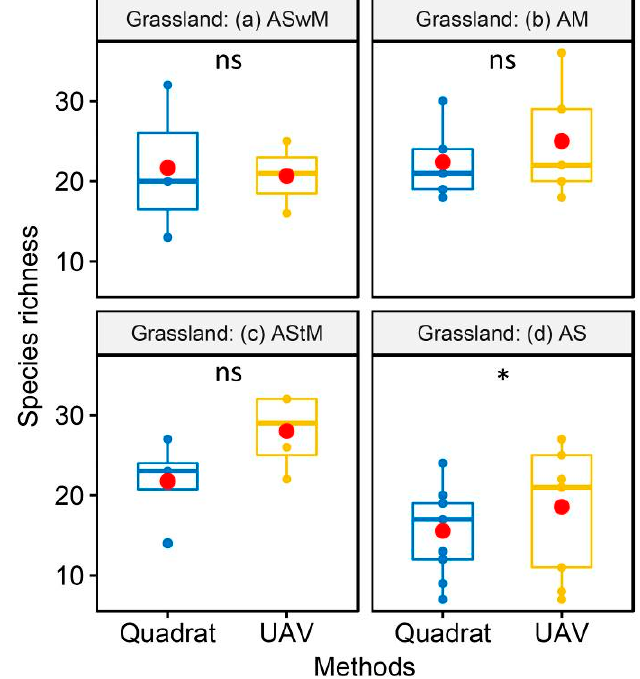
Figure 5. Species richness within sampling units of the Quadrat method and the UAV method. * and ns indicate that the significant effects at p<0.05 and no significant difference, respectively. ASwM, AM, AStM and AS indicate alpine swamp meadow, alpine meadow, alpine steppe meadow and alpine steppe, respectively.